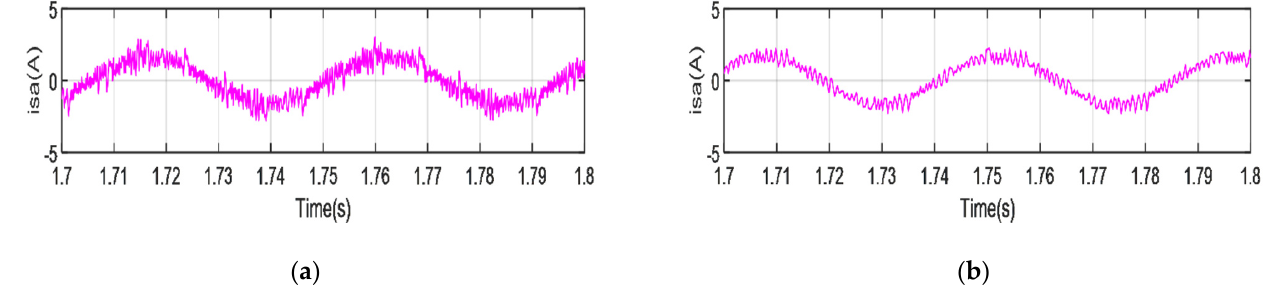
Figure 14. Torque response: ( a ) conventional inverter; ( b ) five-level inverter.